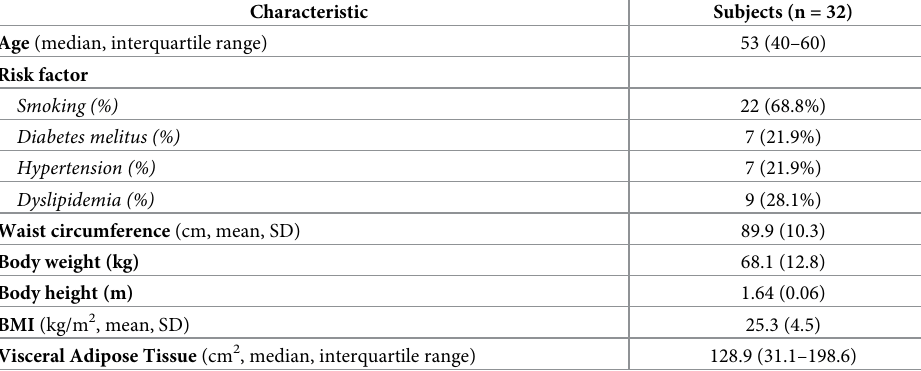
Table 1. Characteristics of